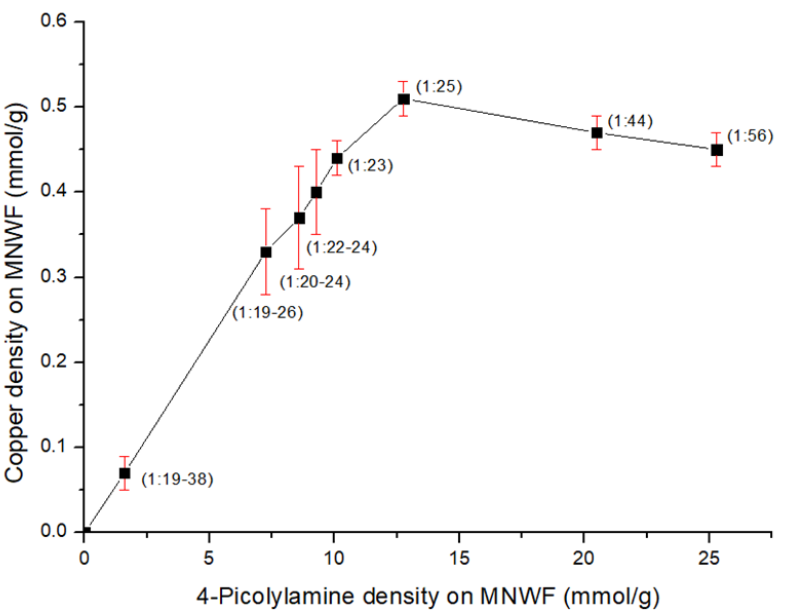
Figure 8. Dependence of copper ion density on 4-AMP density (the content in parentheses is the ratio of Cu mole:4-AMP mole).